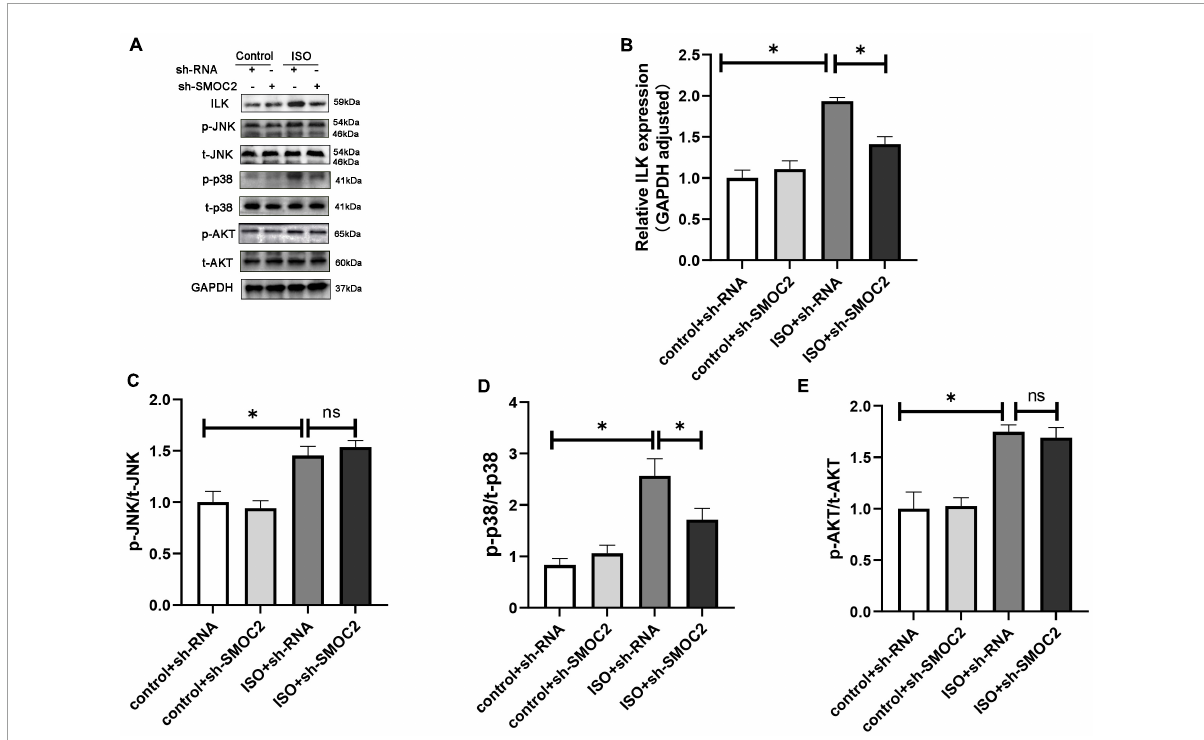
FIGURE4 Targeting SMOC2 expression attenuates myocardial fibrosis via the ILK/p38 pathway. (A–E) Representative Western blots and quantitative results of ILK, t-AKT, p-AKT, t-JNK, p-JNK, t-p38, and p-p38 ( n = 6). ∗ p < 0.05. n.s.,